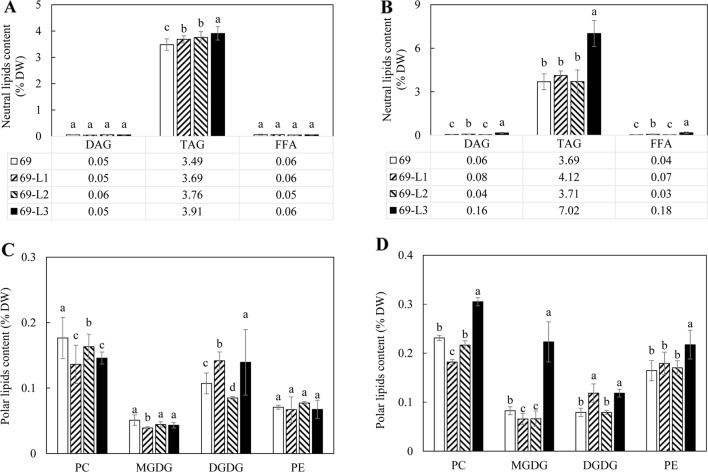
Contents of neutral and polar lipids in the potato tubers of the HO69 (open bars) and three super-transformed lines, 69-L1 (bar with upward trend), 69-L2 (hatched bars) and 69-L3 (black bars) at two developmental stages. (A) Neutral lipids contents at the flowering stage; (B) Neutral lipids contents at the mature stage; (C) Polar lipids contents at the flowering stage; (D) Polar lipids contents at the mature stage. The data represent the mean values ± SD of three biological replicates. Letters (a, b, c) above the bars are based on LSD, bars marked with different letters are statistically significantly different at P < 0.05.